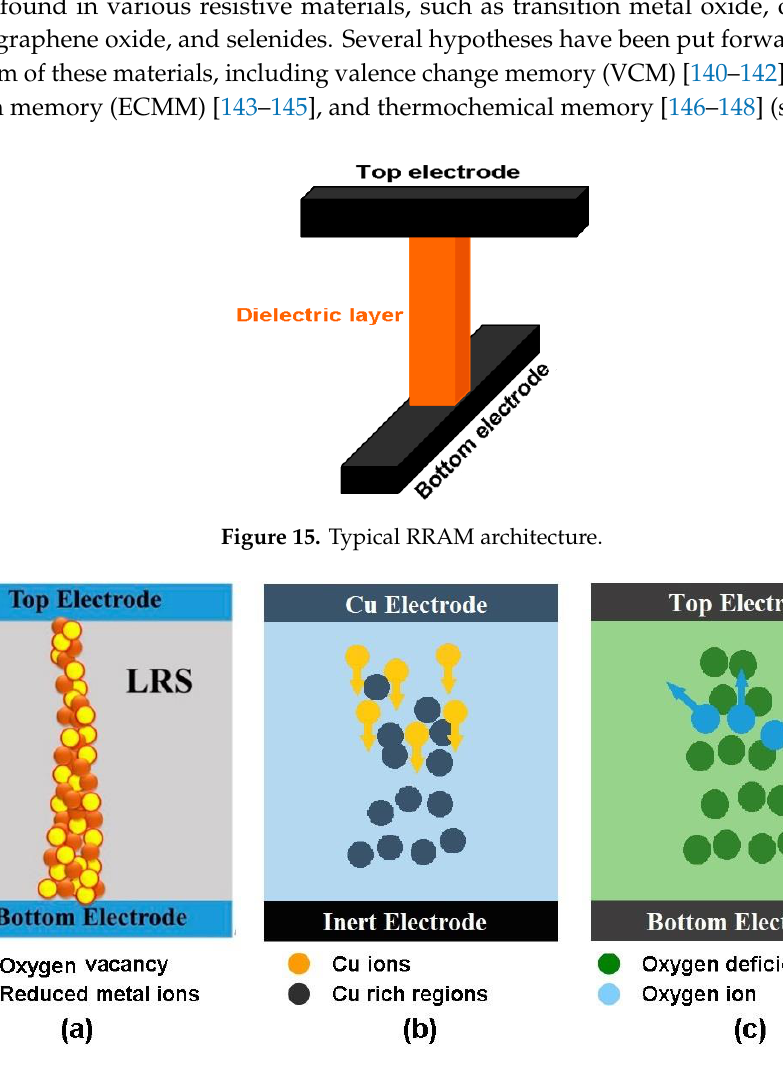
Figure 16. Resistive switching mechanism for: ( a ) VCM (valence change memory); ( b ) ECMM (electrochemical metallization memory); and ( c ) thermochemical memory (( a ) is reprinted with permission from [148]; ( b , c ) are reprinted with permission from